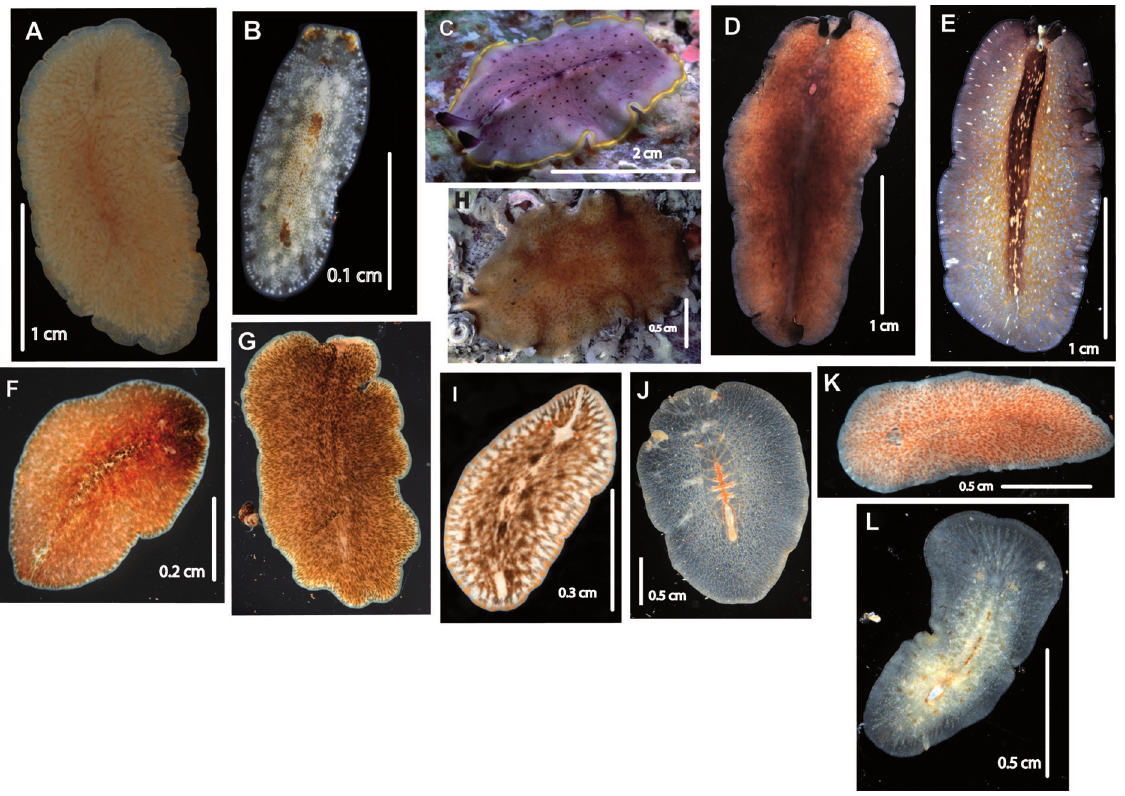
Fig. 7. A . Anonymus ruber Cuadrado, Moro & Noreña, 2017 from Cape Verde. B . Cycloporus gabriellae Marcus, 1950 from Cape Verde. C . Prostheceraeus moseley Lang, 1884 from Cape Verde. D . Pseudoceros velutinus (Blanchard, 1847) (transmitted light) from Cape Verde. E . Monobiceros langi Faubel, 1984 from Cape Verde. F . Stylochus pilidium (Götte, 1881) from South Morocco. G . Stylochus pillidium (Götte, 1881) from Azores. H . Stylochus sp. from South Morocco. I . Stylochus neapolitanus (Delle Chiaje, 1841–1844) from Madeira. J . Planocera pellucida (Mertens, 1833) from Canary Islands. K . Discocelis tigrina (Blanchard, 1847) from Canary Islands. L . Gnesioceros sargassicola (Mertens, 1833) from Canary